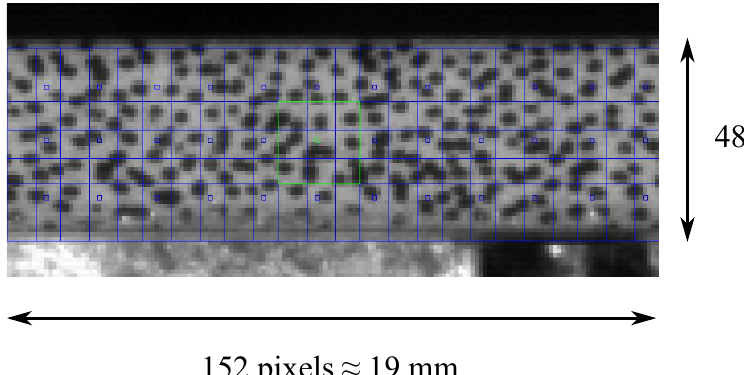
Figure 5. Zoom on an image captured by the camera.